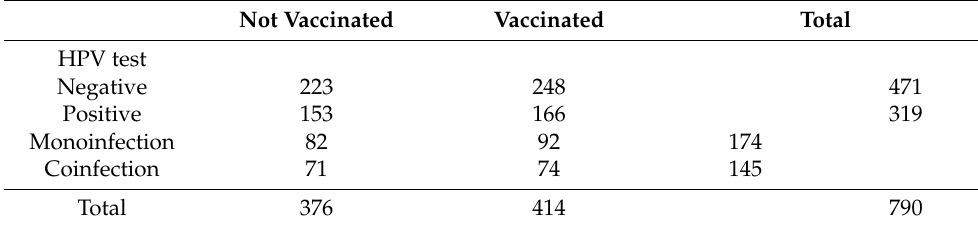
Table 3. HPV co-infections and vaccination